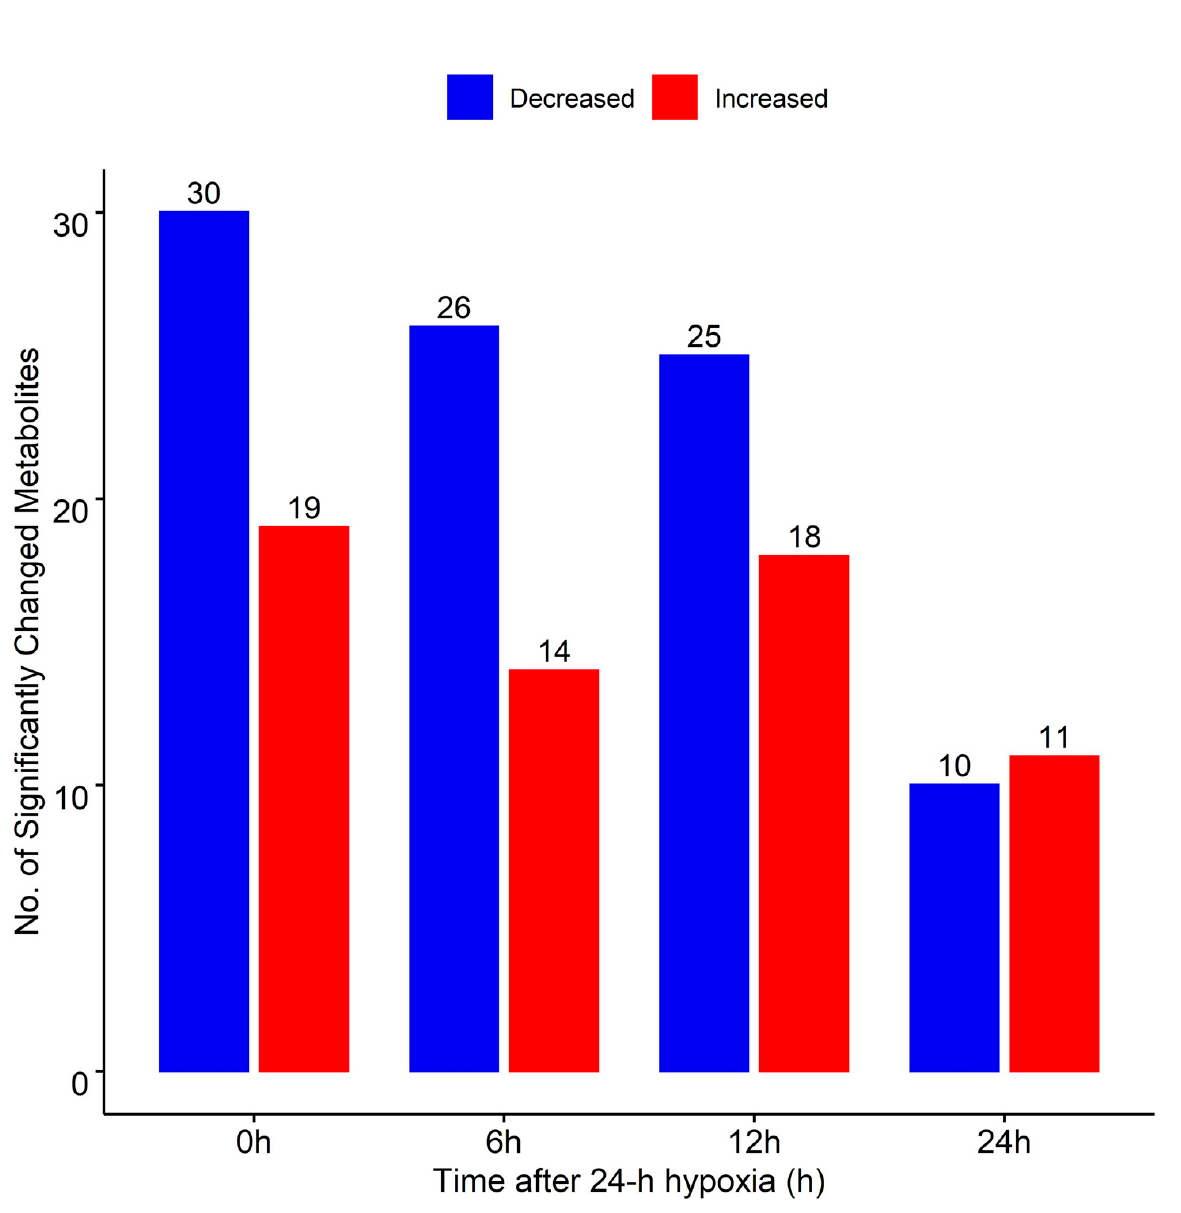
Figure 3. Overview of significantly changed metabolic features in response to hypoxia and reoxy- genation. The Student’s t -test was performed to identify significantly changed metabolites between the treatment and control samples at each time point. Total significantly increased and decreased metabolites at each time point are shown.